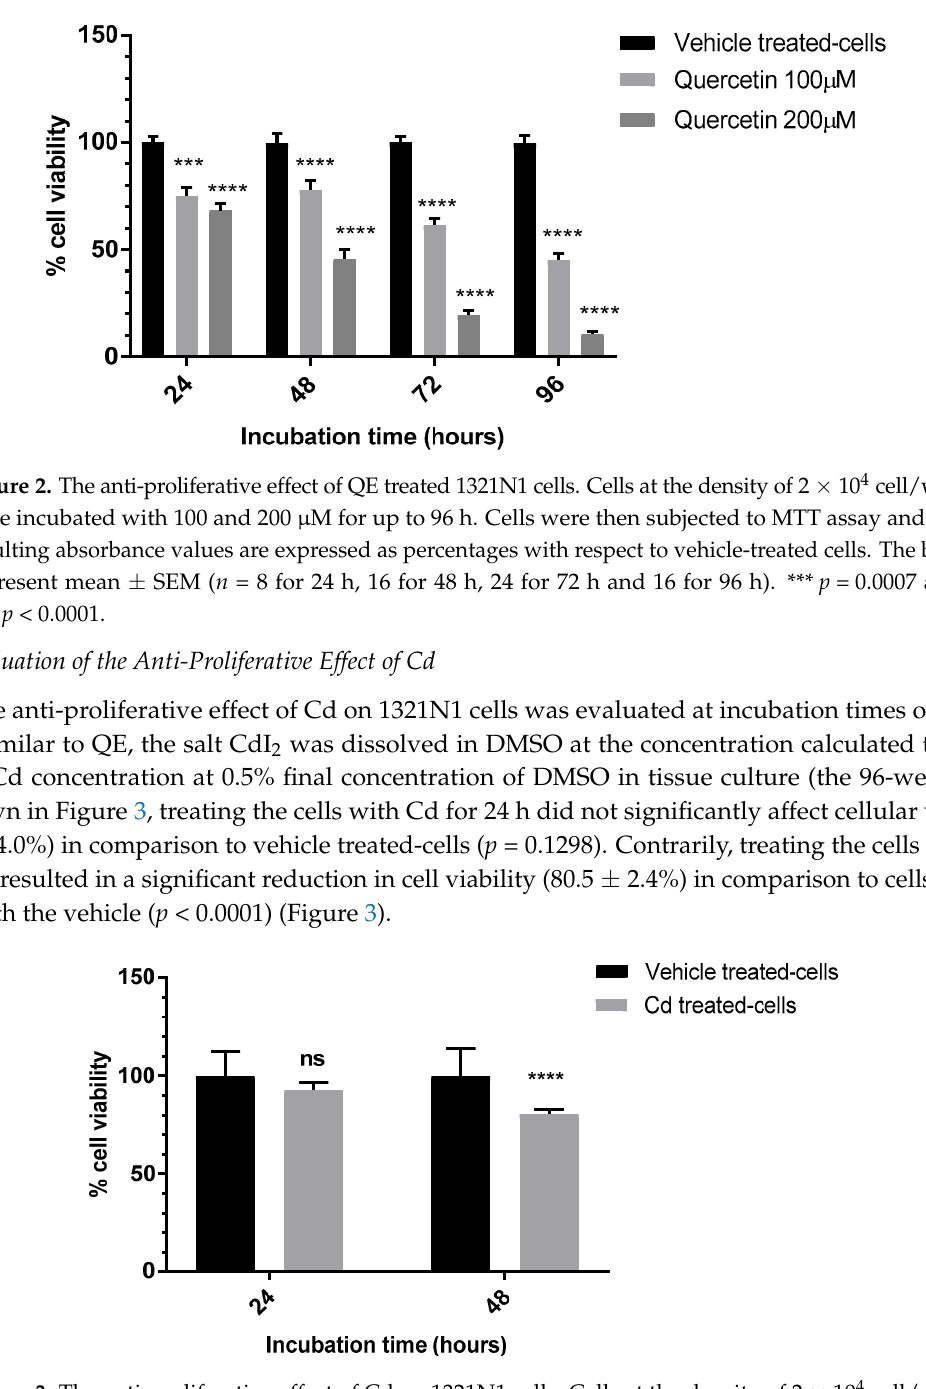
Figure 3. The anti-proliferative effect of Cd on 1321N1 cells. Cells at the density of 2 × 10 4 cell/well were incubated with 16 µM Cd for up to 48 h. Cells were then subjected to MTT assay and the resulting absorbance values are expressed as percentages with respect to vehicle-treated cells. The bars represent mean ± SEM ( n = 40). **** p < 0.0001; ns, not significant.